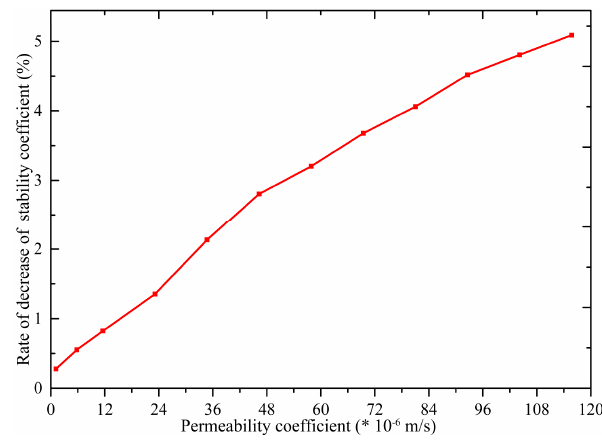
Figure 12. RDSC for water level drawdown at different speeds.